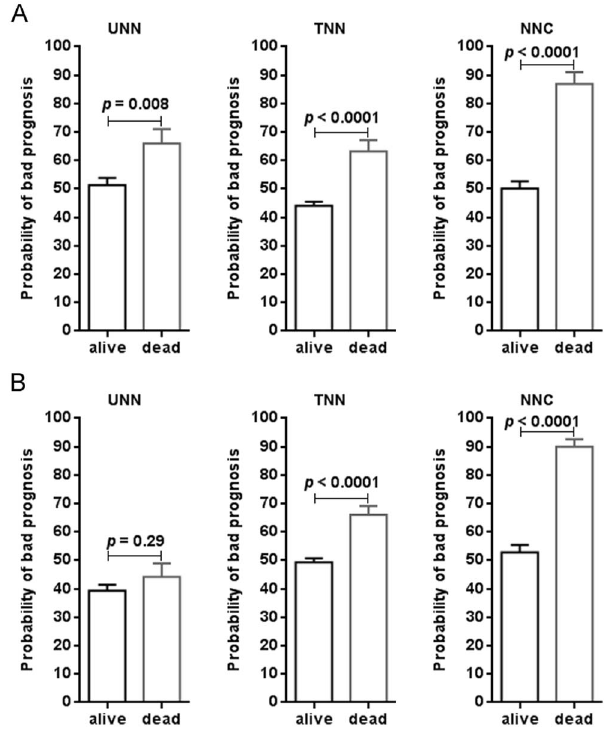
Figure 5. Comparison of bad prognosis likelihood between external validation patients with different survival statuses. A) Normal miR-93 expression input. B) Disturbed miR-93 expression input. UNN: untransformed neural network; TNN: transformed neural network; NNC: neural network cascade. All data are expressed as mean 6 SEM.